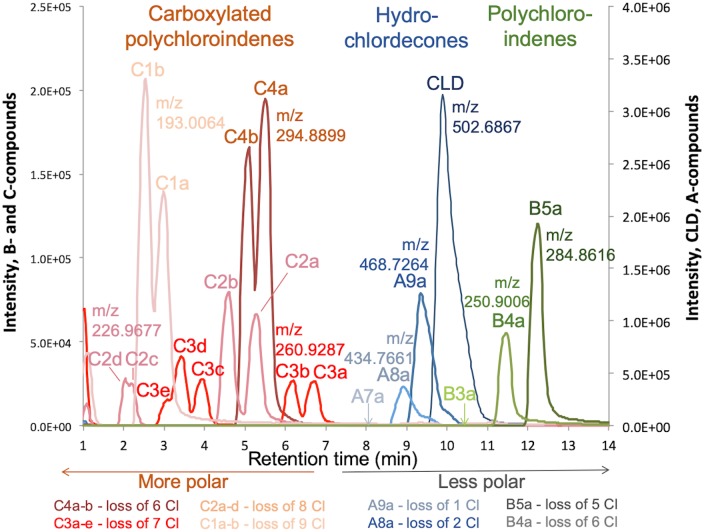
Chromatograms of chlordecone and its dechlorinated metabolites.Results are from a slurry sample from transfer GT20, taken after approximately 7.5 years of incubation. Samples were analyzed by LC/MS, equipped with ESI, in negative mode. Observed m/z values (monoisotopic) for the different compounds were; 502.6879 (CLD, [C10Cl10O2H]-), 468.7264 (A9a, [C10Cl9O2H2]-), 434.7661 (A8a, [C10Cl8O2H3]-), 284.8616 (B5a, [C9Cl5H2]-), 250.9006 (B4a, [C9Cl4H3]-), 294.8899 (C4a-b, [C10Cl4O2H3]-), 260.9287 (C3a-e, [C10Cl3O2H4]-), 226.9677 (C2a-d, [C10Cl2O2H5]-), 193.0064 (C1a-b, [C10ClO2H6]-) (see details in S6 Table). Metabolites m/z 400.8042 (A7a, [C10Cl7O2H4]-) and 216.9382 (B3a, [C10Cl7O2H4]-) were not observed in the illustrated sample but in some other samples in the study. Arrows indicate observed retention times for these two metabolites. CLD, MHCLD, DHCLD and THCLD are quantified/reported in the forms of CLD hydrate, MHCLD hydrate, DHCLD hydrate and THCLD hydrate.